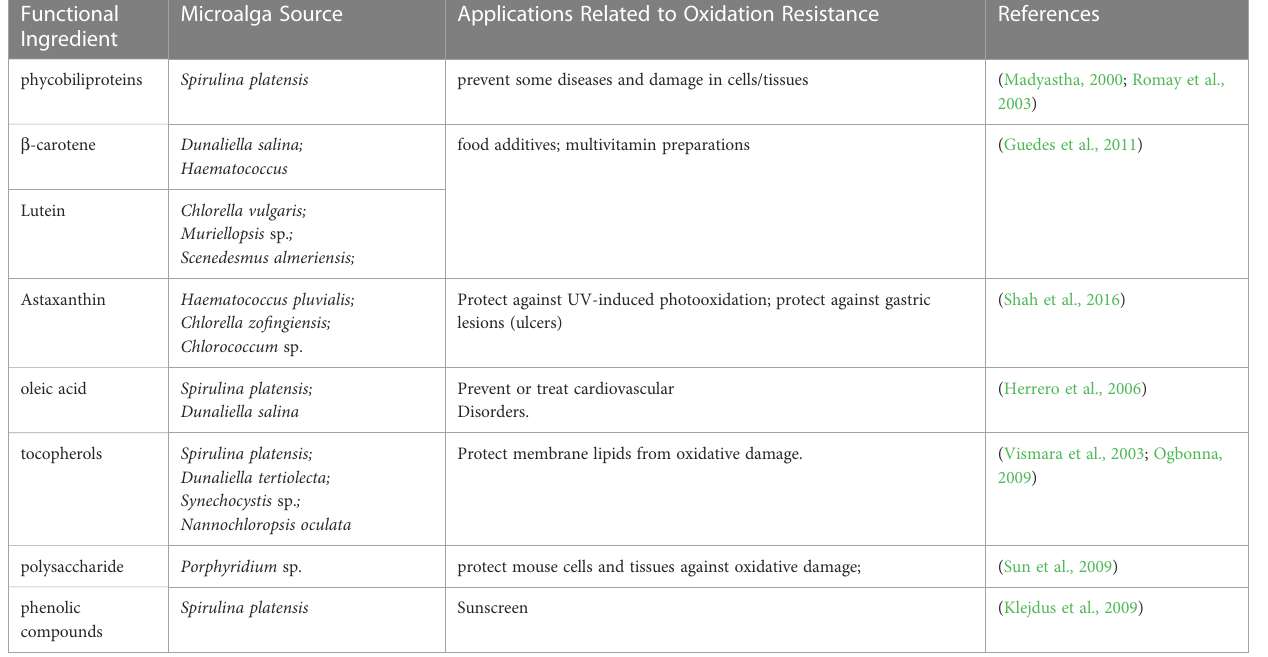
TABLE 6 Active antioxidant functional ingredients in common microalgae. Functional